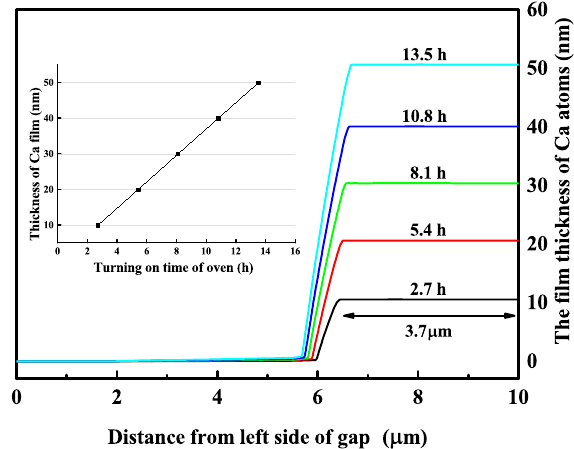
Figure 3. (Color online) The different adatoms’ thicknesses on the electrode gap are calculated at Ca vapor pressure 3 × 10 − 3 Pa and the temperature 900 K of the atomic oven. ( 10,20,30,40,50 ) nm thick films are generated by turning on the atomic oven for ( 2.7,5.4,8.1,10.8,13.5 ) h, and the widths of these adatoms films are approximately 3.7 µ m. The different thicknesses of the adsorbent layer are linearly dependent on the exposure time to the atomic beam in the